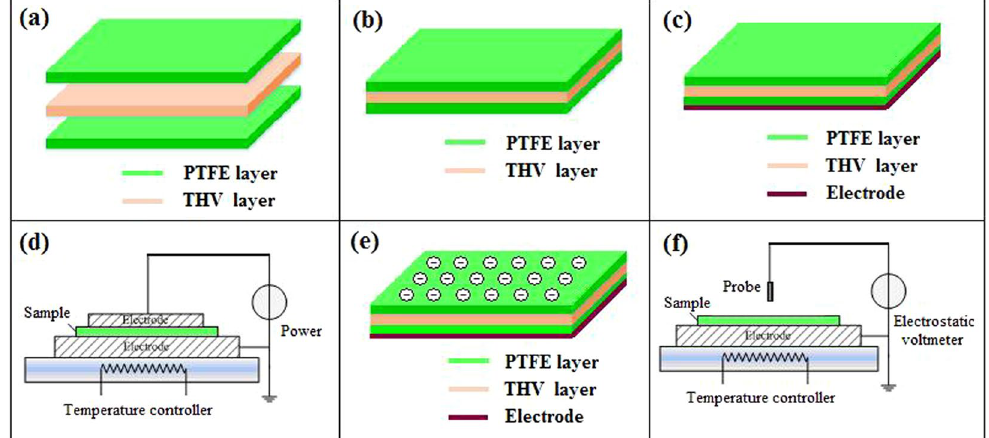
Figure 4. Illustration of flexible PTFE/THV/PTFE electret membrane preparation. ( a ) Constitution of PTFE/ THV/PTFE membrane; ( b ) Structure of hot pressed membrane; ( c ) Metalized membrane on the bottom surface with aluminum; ( d ) Configuration schematic of thermal charging; ( e ) Surface charge distribution of electret membrane; ( f ) Configuration schematic of surface potential